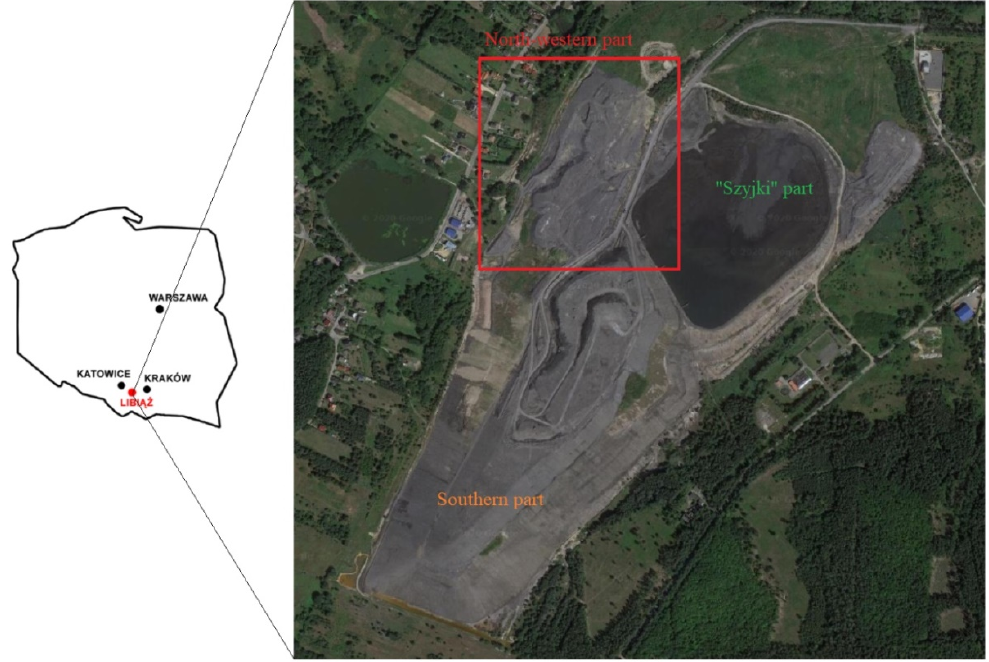
Figure 3. Location of the Janina mine waste